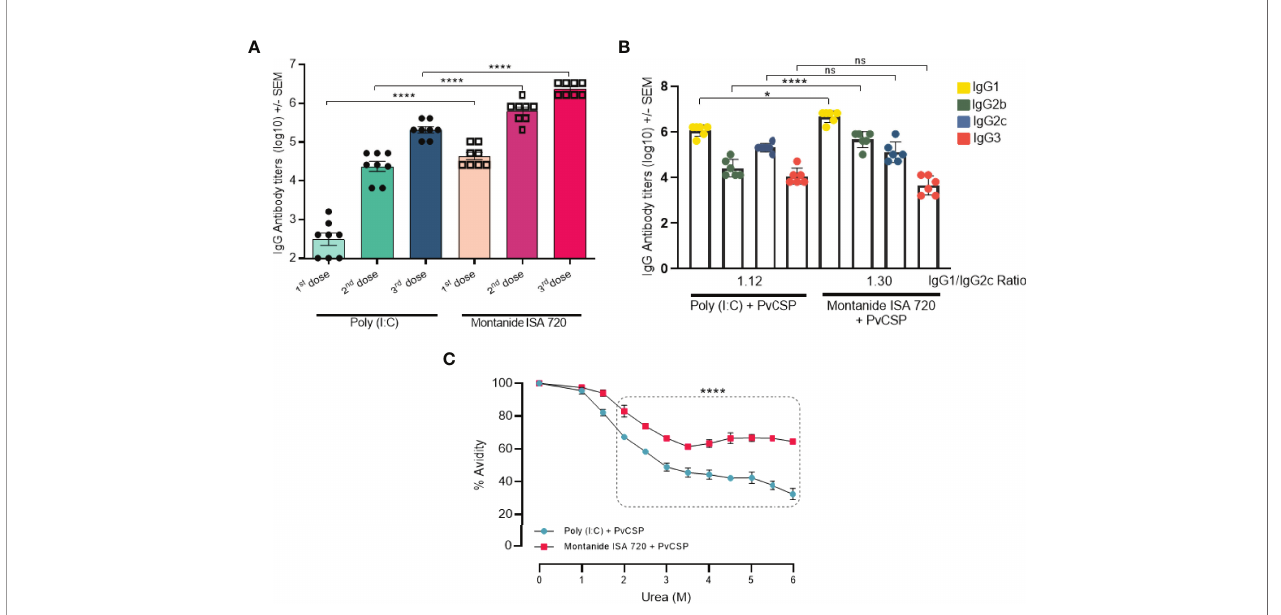
FIGURE 1 | Montanide ISA 720 and Poly (I:C) elicit different antibody response pro fi les. C57BL/6 mice (n = 6) were vaccinated with three doses of PvCSP + Montanide ISA 720 or PvCSP + Poly (I:C). (A) PvCSP-speci fi c IgG titers (Log) elicited 14 days after each immunizing dose were determined by ELISA. (B) Anti- PvCSP IgG1, IgG2b, IgG2c, and IgG3 subclasses were determined by ELISA 14 days after the last immunization. (C) Antibody af fi nity to PvCSP was measured after 30min of incubation in urea gradient solutions. Statistical signi fi cance was calculated on 6M urea point. Asterisks denote statistical differences; *p < 0.05; ****p < 0.0001; ns, not signi fi cant